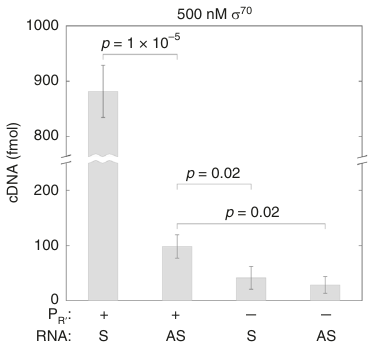
Fig. 4 Amounts of both sense and antisense transcripts depend on the sense promoter. Measurements of the amounts of RNAs produced from bulk transcription reactions on templates with an unmodi fi ed (Fig. 1a) or a scrambled ( “ Methods ” ) λ P R ′ promoter. RNAs were reverse transcribed using sense (S) or antisense (AS) speci fi c primers (Supplementary Fig. 5A) and the amounts of cDNA produced were measured by qPCR. Graph shows mean ± s.e.m. of three experiments. All individual measurements from these and additional control samples are shown in Supplementary Fig.